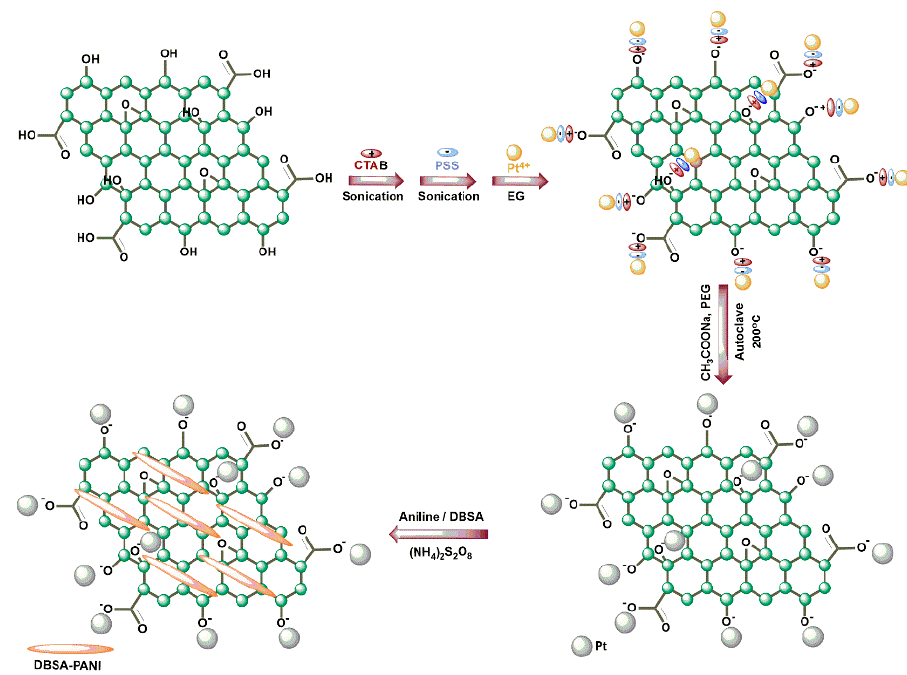
Figure 1. Schematic illustration for the synthesis of a GO/Pt/DBSA–PANI nanocomposite.